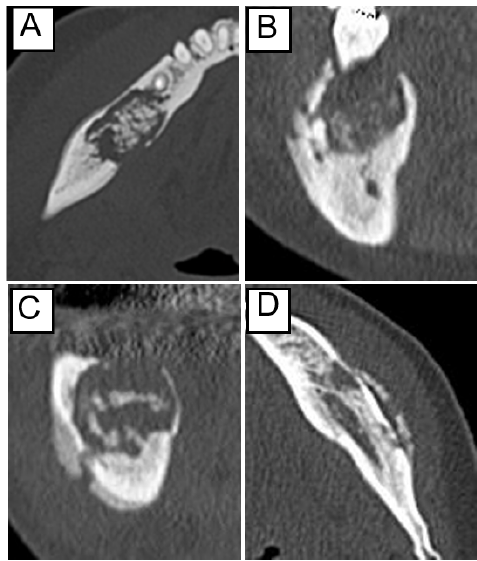
Figure 1. Examples of CT findings before treatment: ( A ) separation of the sequestrum, ( B ) osteolysis above the mandibular canal, ( C ) osteolysis including the mandibular canal, and ( D ) periosteal reaction.